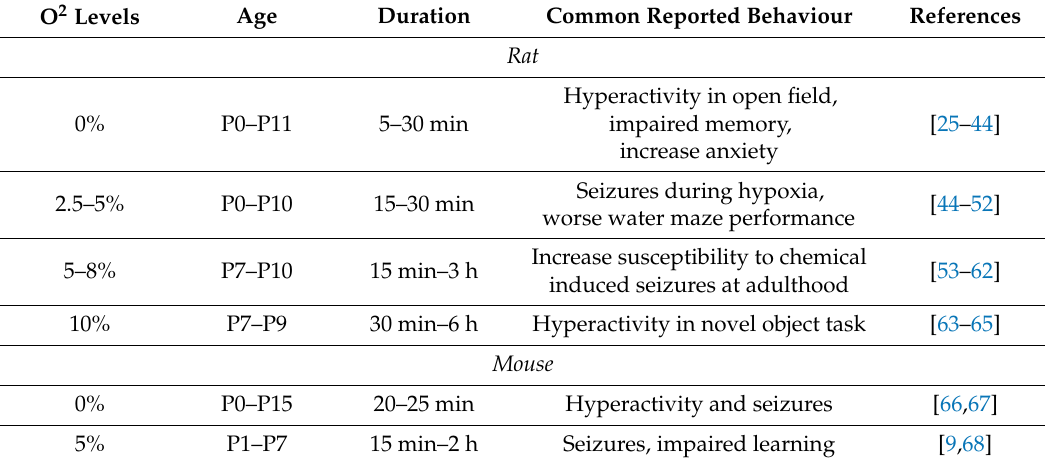
Table 1. Rat and mouse models for hypoxia–ischaemia. The experimental designs employed, along with the resultant behavioural characteristics and O 2 levels.